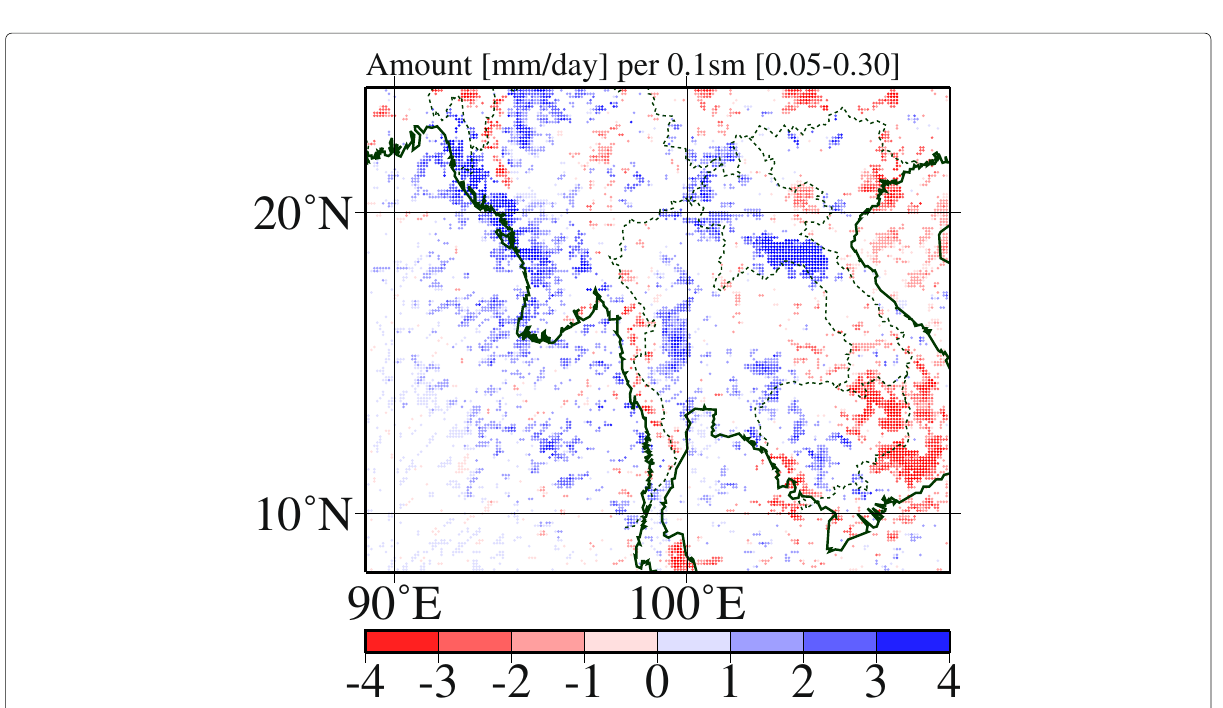
Fig. 12 Same as Fig. 3 but for rainfall amount under the drier conditions. The blue color indicates an increase in rainfall amount with soil moistening. Under the drier conditions, we used the SM005, SM010, SM015, SM020, SM025, and SM030 experiments for the calculation of PSMsens. The unit is mm day − 1 per 0.1 increase in soil